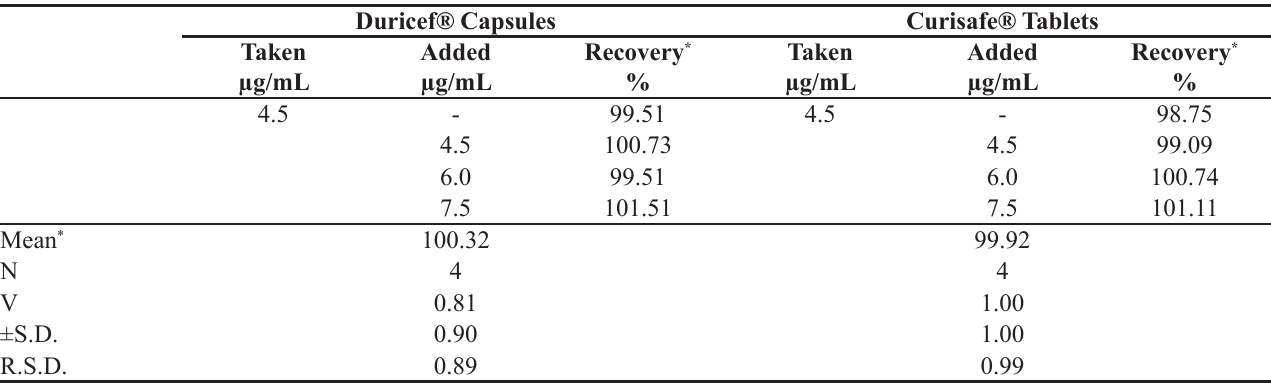
TABLE V - Application of standard addition technique for the determination of cefotaxime, cefoperazone, ceftazidime in their pharmaceutical formulations